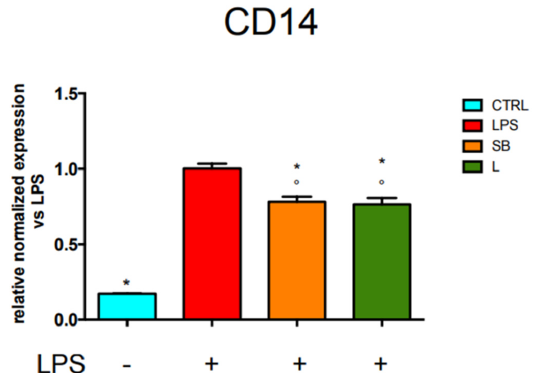
Figure 4. RT-PCR analysis of CD14 gene expression in BV-2 cells treated with chestnut leaf or spiny bur extracts. BV-2 cells were treated with spiny bur or leaf extracts (0.5 mg/mL) for 3 h, then stimulated (or not) with LPS (0.5 μ g/mL) for a total of 24 h. At the end of incubation, RNA was extracted from cells and samples were subjected to RT-PCR analysis using a specific primer for CD14, as reported in the Materials and Methods section. The relative mRNA content of CD14 was normalised to untreated cells stimulated with LPS. Relative quantification is obtained as explained in the Materials and Methods section; results are expressed as means ± SEM of three independent experiments. Statistical analysis was performed by Fisher’s LSD test following one-way ANOVA. ° p < 0.05 significantly different from control cells; * p < 0.05 significantly different from LPS-treated cells.